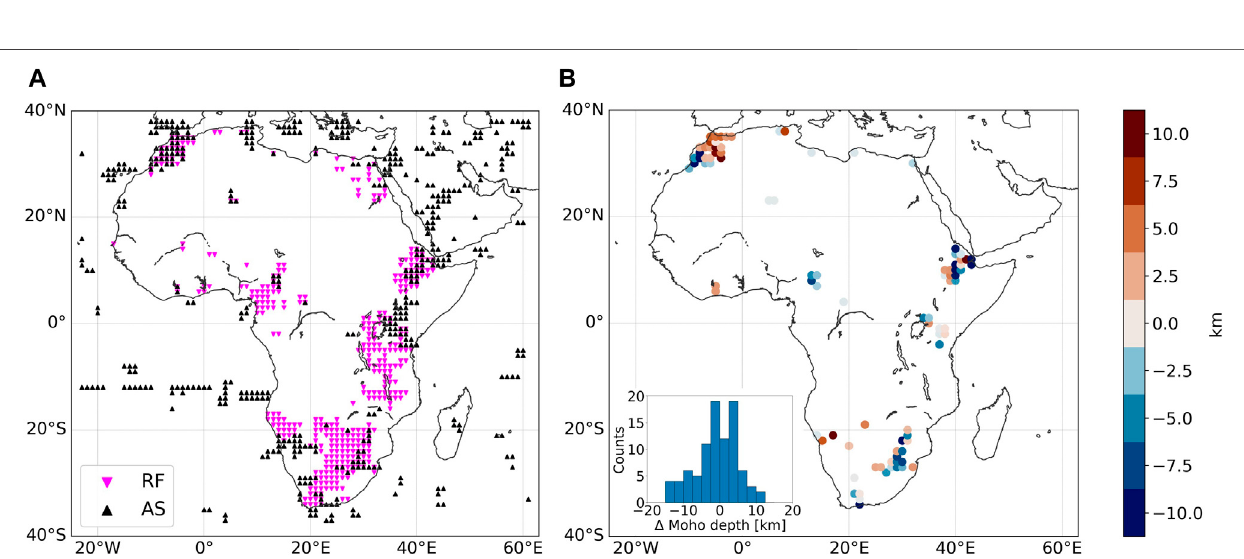
FIGURE 1 | Vertical gravity gradient at 225 km height, corrected for topographic and far fi eld isostatic effects. This data set serves as input for the inversion.